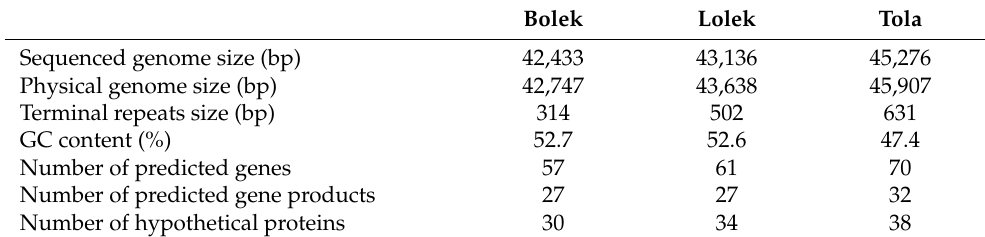
Table 3. Characteristics of the Bolek, Lolek, and Tola genomes.